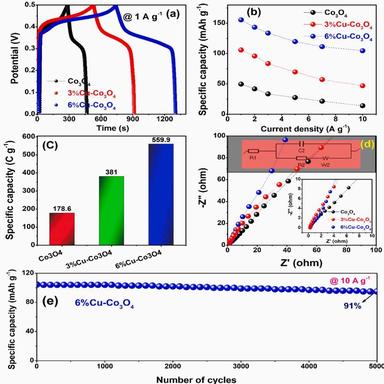
Comparison of GCD curves at 1 A g− 1 (a), specific capacity against current density plot (b), bar graph of specific capacity in terms of C g− 1 (c), and Nyquist plot (d) of undoped and Cu-doped electrodes. Cyclic stability of the 6%Cu–Co3O4 electrode at 10 A g− 1 .